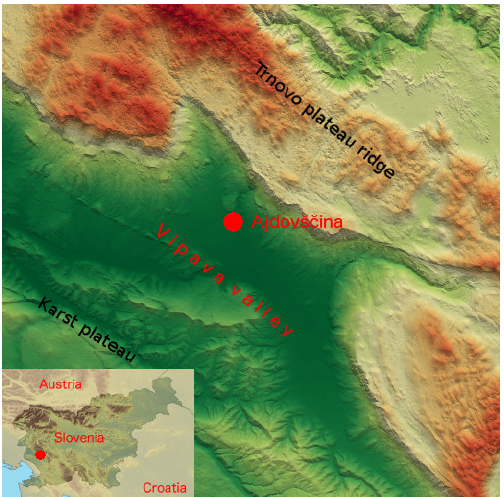
Figure 1. Topographic features of the Vipava Valley, located in the southwestern part of Slovenia, approximately 25km from the Adriatic coast (inlay). On its southern side, it is confined by the Karst plateau (up to 300m a.s.l.) and on its northern side by the steep Trnovo plateau ridge, which rises up to about 1000m a.s.l (http://gis.arso.gov.si). LiDAR was deployed at Ajdovšˇcina (45.87 ◦ N, 13.90 ◦ E, 125m